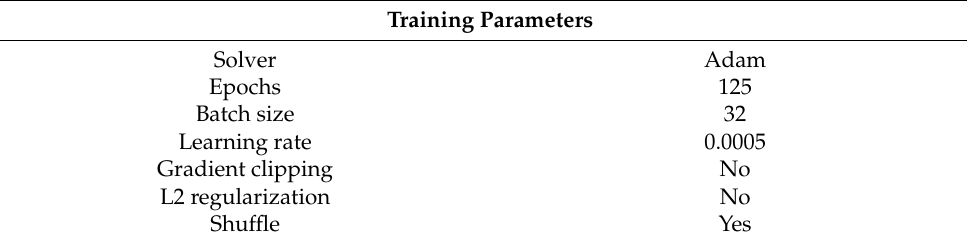
Table 19. Training parameters for UNet with simplified classes on